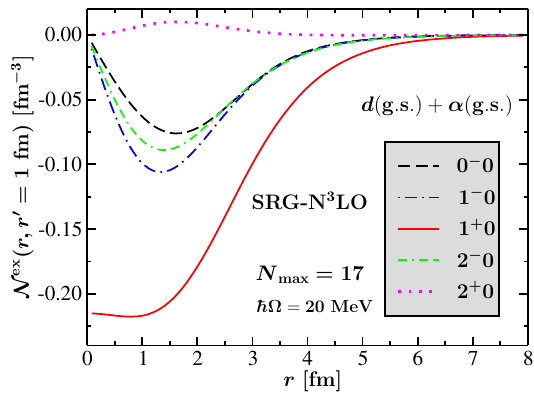
(cid:3) − r ) ( r (cid:3) , r ) − δ ( r for the d (g.s.) + α (g.s.) channels as a function (cid:9)(cid:9) r (cid:3) r of the relative coordinate r at r (cid:3) = 1 fm, using the SRG-N 3 LO NN potential [44] at (cid:2) Ω = 20 MeV. E ff ects of the Pauli-exclusion principle are visible partcularly in the 1 + 0